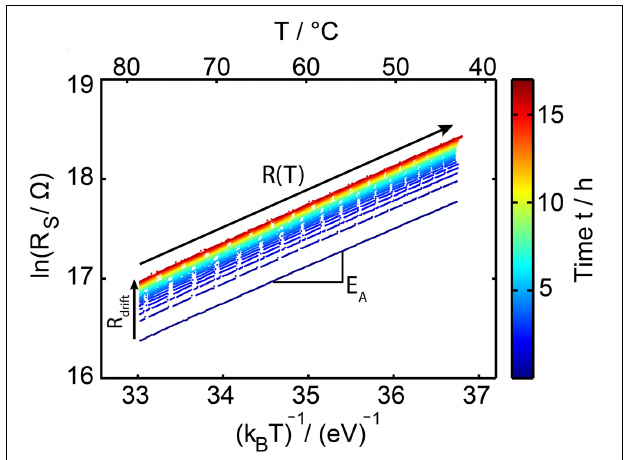
FIGURE 8 | Arrhenius plot of the measured sheet resistance data on GeTe. For each temperature dip a single line is shown. The line color indicates the drift time ranging from several seconds up to about 17h. Upon drifting (going from dark blue to dark red colors) the straight line continuously shifts to higher values in resistance. The interruptions within each line are due to the limited amount of data which our Keithley SMU can store internally. Time-resolved data for the activation energy of conduction (slope) as well as the prefactor (intercept for T approaching infinity) within the Arrhenius law are determined by fits on the individual curves at the cooling ramp during each temperature dip.